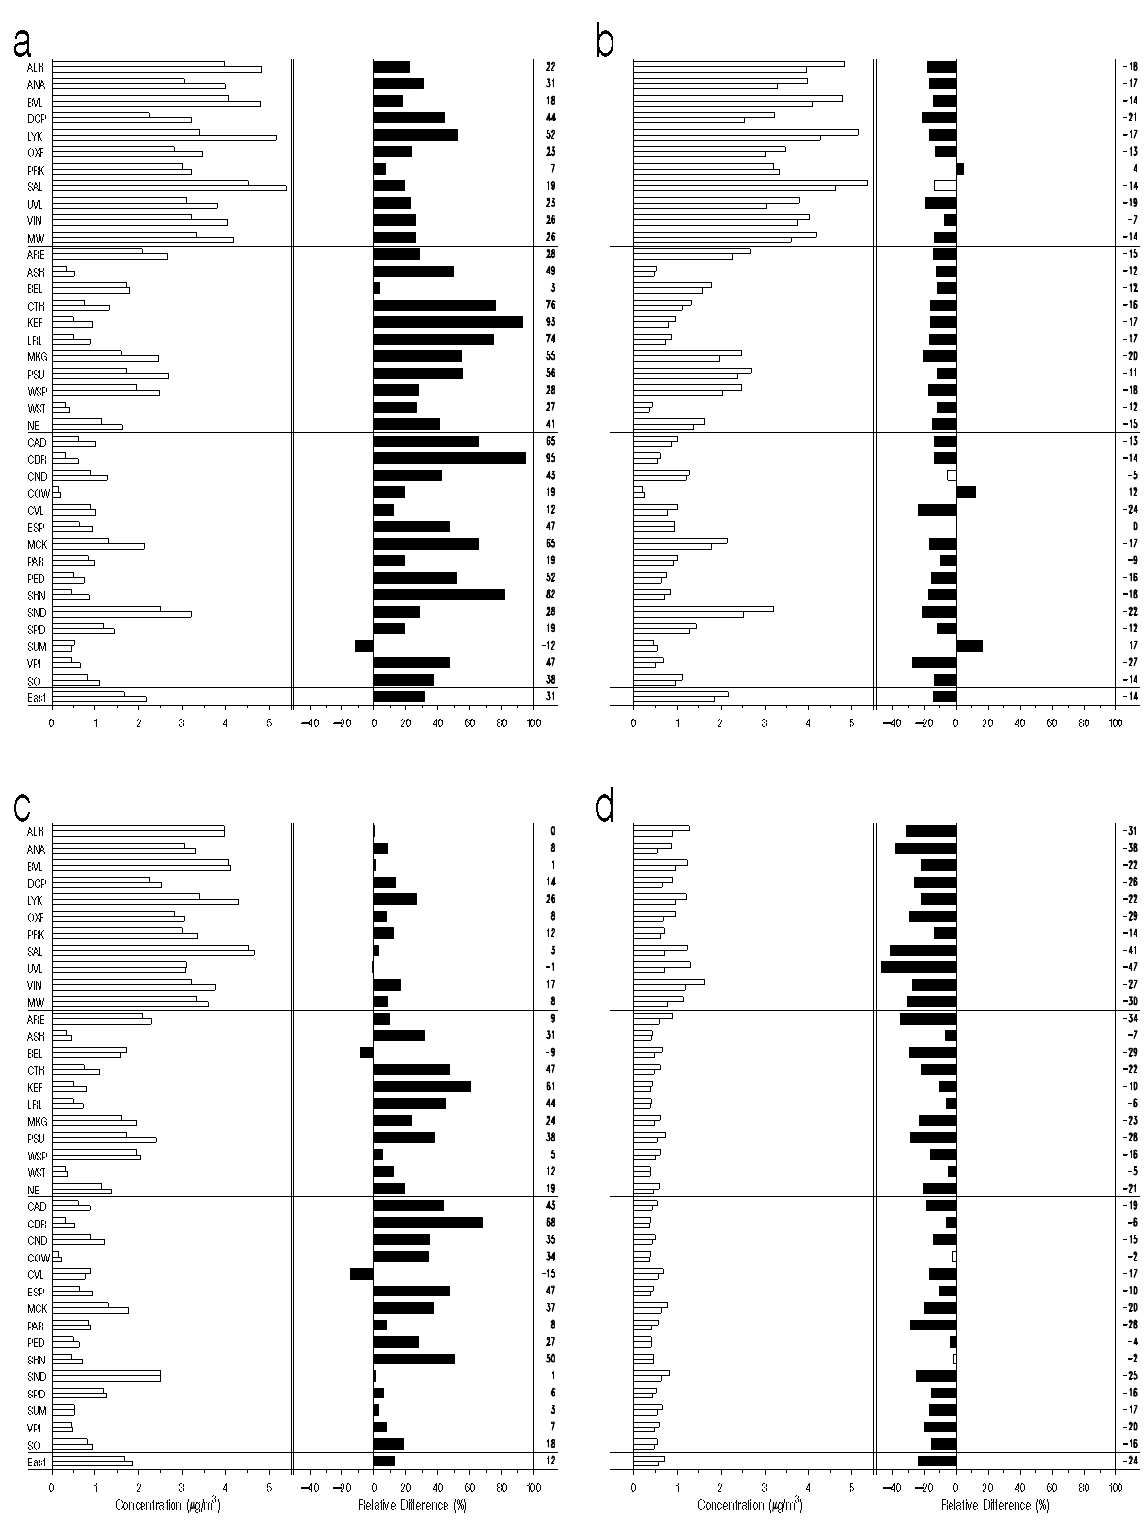
Figure 7. Site- and region-specific seasonal aerosol NO 3 concentration (µgm − 3 , left – upper bar: early period; and lower bar: later period) and period-to-period relative changes (%, right and bottom) for (a) P1-to-P3, W; (b) P3-to-P4, W; (c) P1-to-P4, W; and (d) P1-to-P4, Su. Significance level of period-to-period relative changes indicated by bar fill: black, p ≤ 0 . 05; and open, p> 0 . 05 (NS). Sites are identified by region in the same order as shown in Table